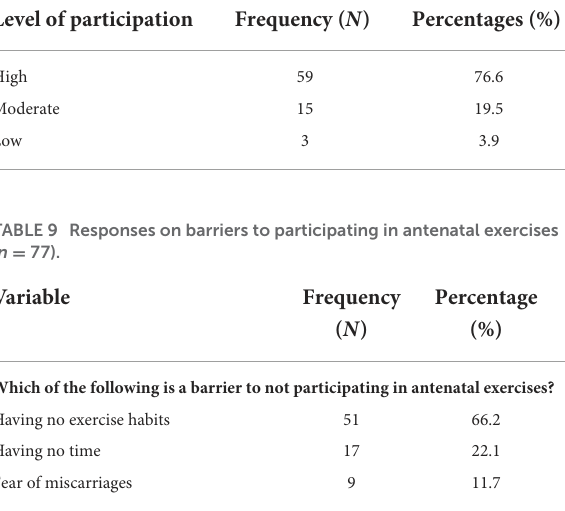
TABLE 8 Participants’ levels of participation in physical activity ( n = 77).